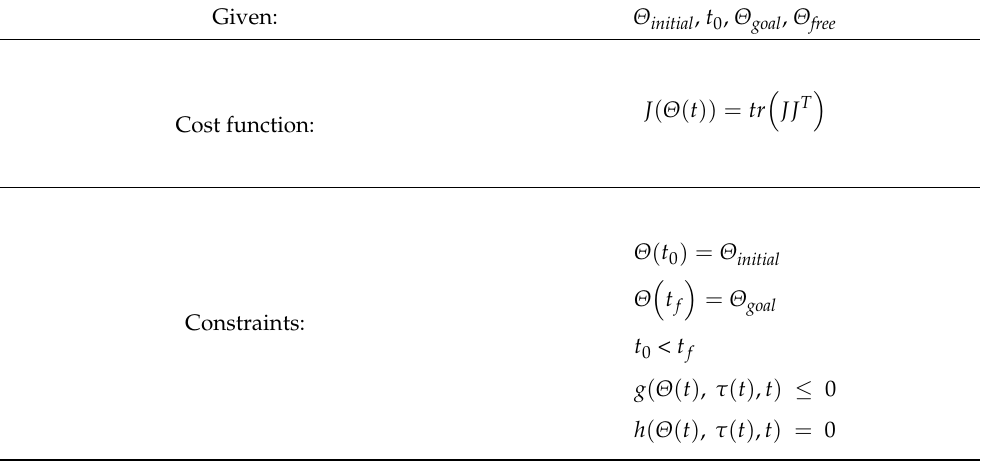
2 d − 1 times compared with the FMT*